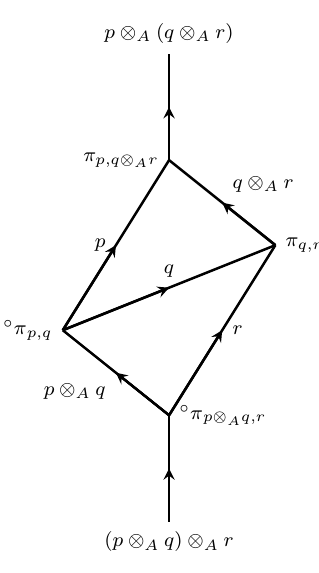
Figure 19 . The associator in Bimod C ( A